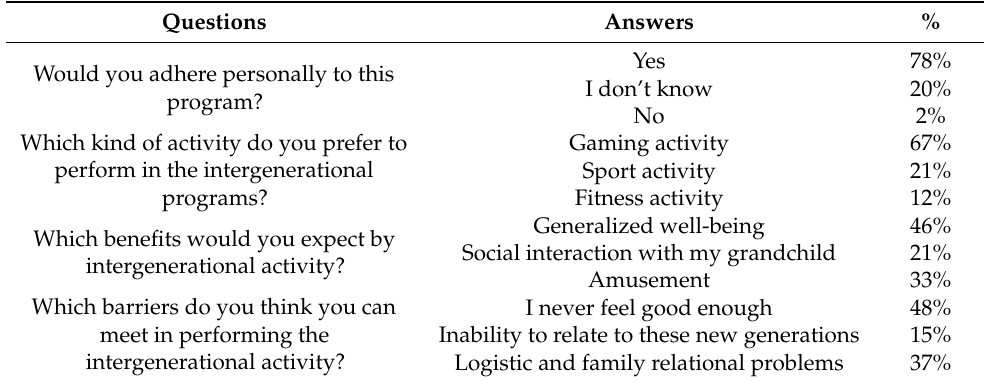
Table 4. Multichoice questions on intergenerational program